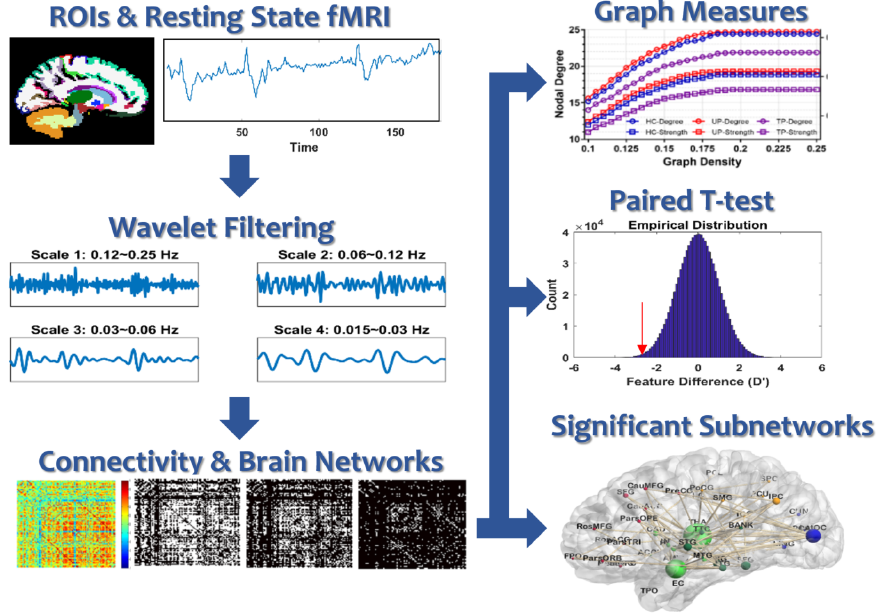
Figure 1. Framework for data analysis.